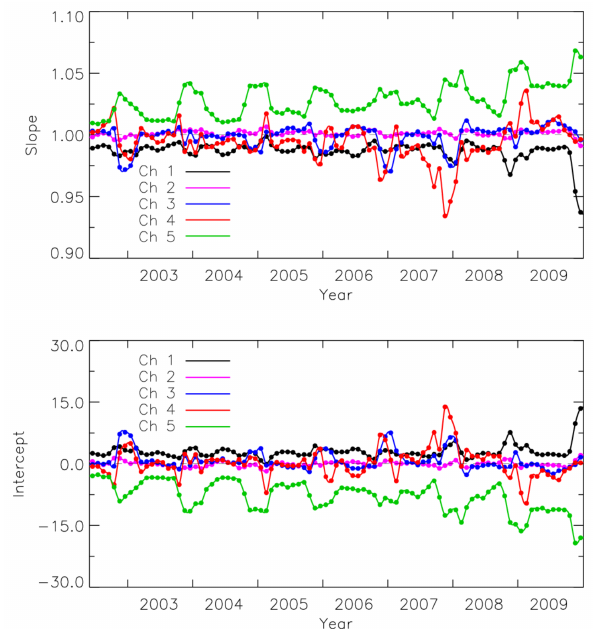
Figure 8. Interpolating monthly coefficients using cubic splines (NOAA-15 vs. NOAA17).